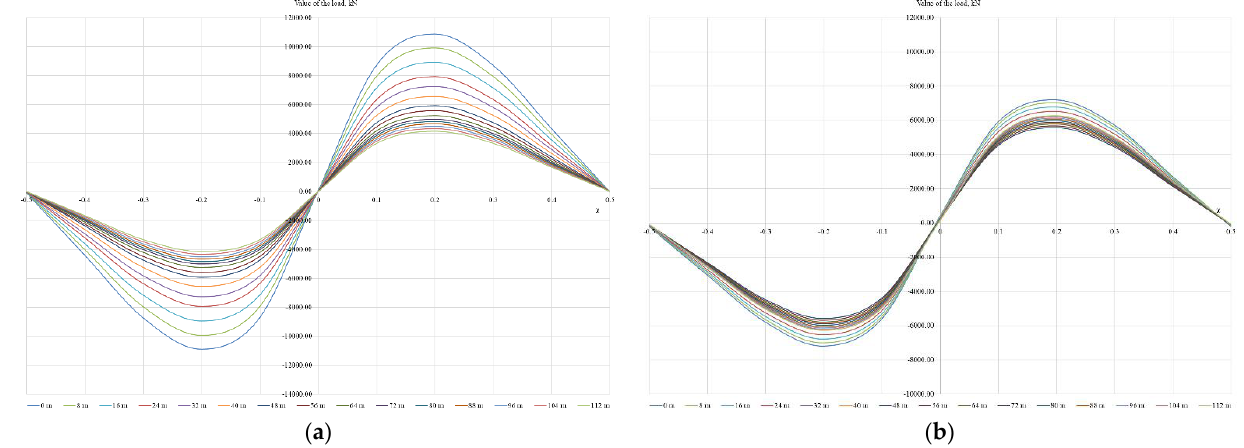
Figure 7. The distribution profile: ( a ) Current velocities; ( b ) Wind velocities.